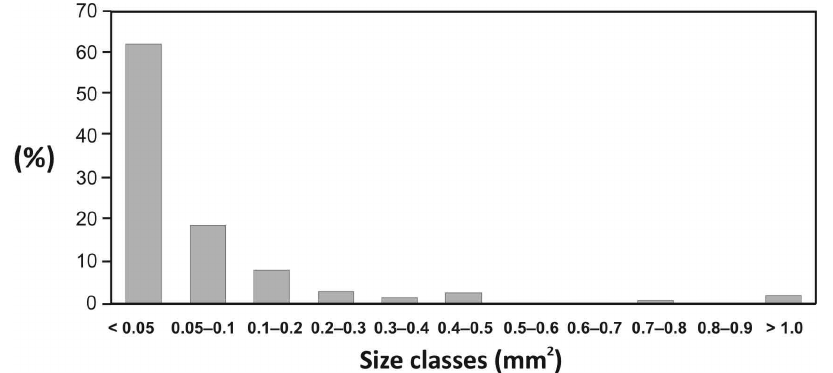
Figure 7. Size classes distribution (%) of the area (in mm 2 ) covered by the overall microplastic frag- ments found in all the samples collected during 2017–2019.